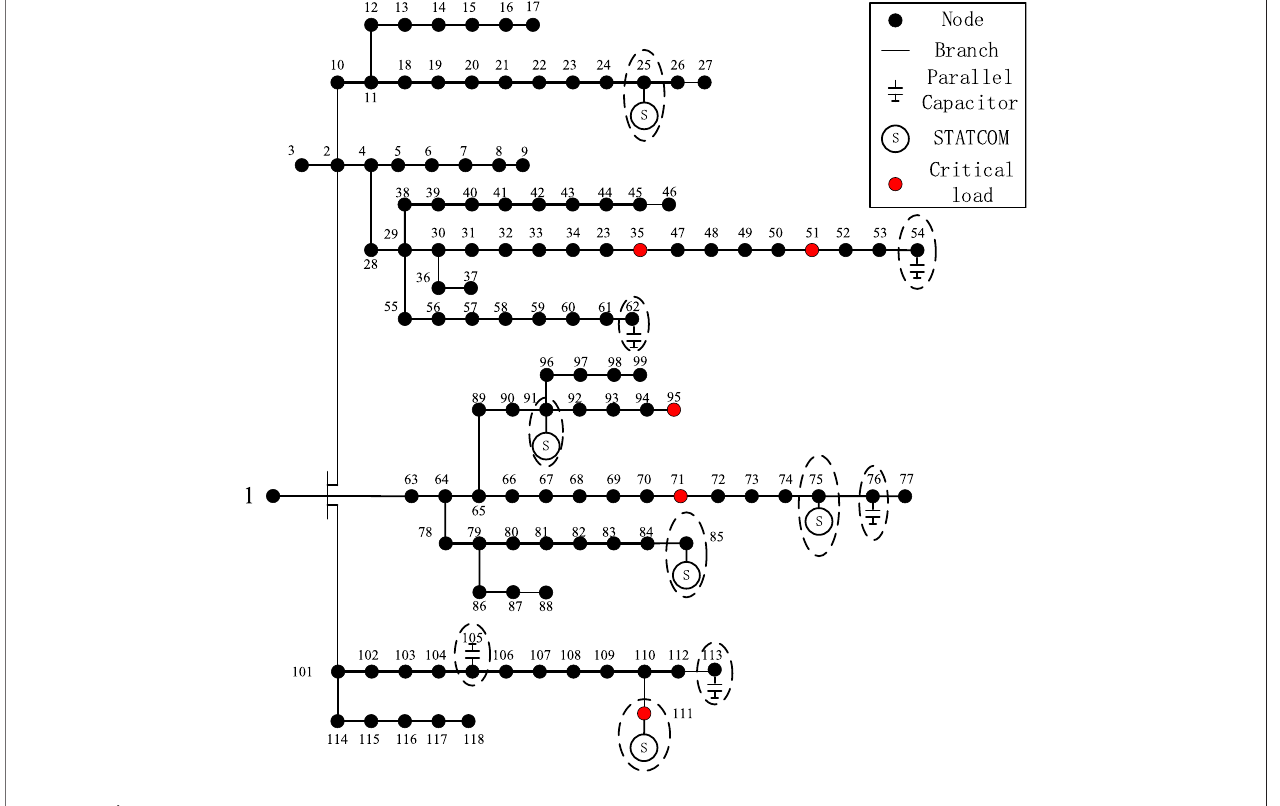
FIGURE 10 | IEEE 118-bus distributed network topology.